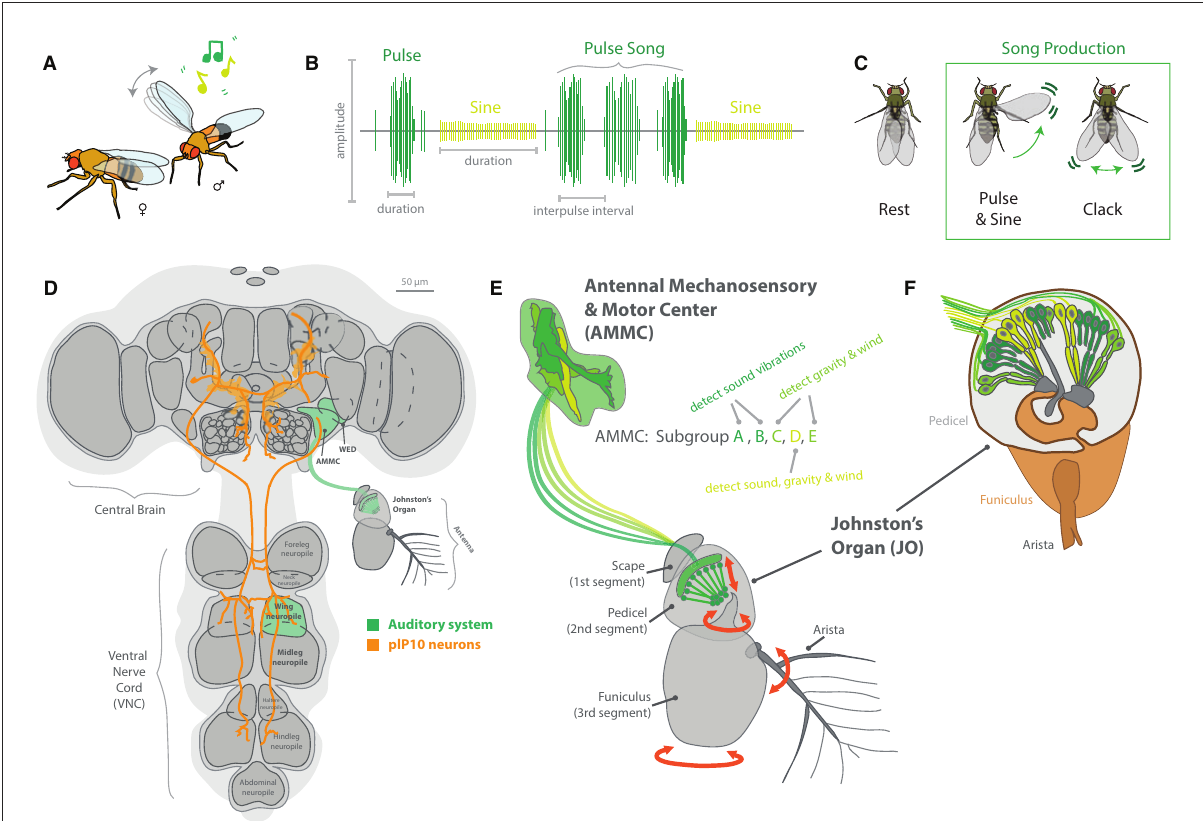
FIGURE8 Auditory signaling and neurobiology in the melanogaster clade of species. (A) For most members of the Drosophila genus, males perform elaborate dances when a female is present. This often includes an auditory component, usually generated by the vibration of one or both